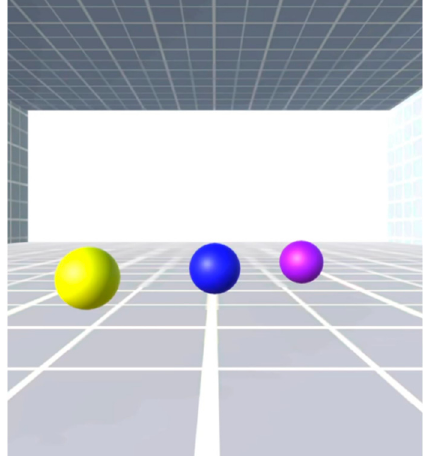
Figure 12. Selecting target objects at different depths whose screen spaces were smaller than in the main experiment and the average fingertip size.